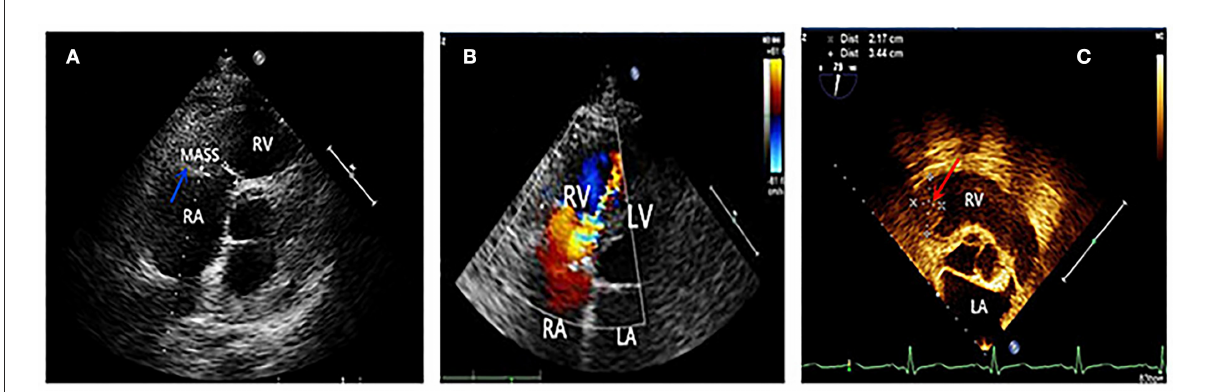
FIGURE1 (A) Blue arrow showed a mass in the right ventricle, which was later confirmed thrombus by surgery. (B) Four chamber view showed the mosaic blood flowing through the stenotic right ventricular inflow tract. (C) Two and a half years after tricuspid valve replacement and thrombectomy, a recurrence of thrombus (indicated by red arrow) was seen in the right ventricular inflow tract by transesophageal